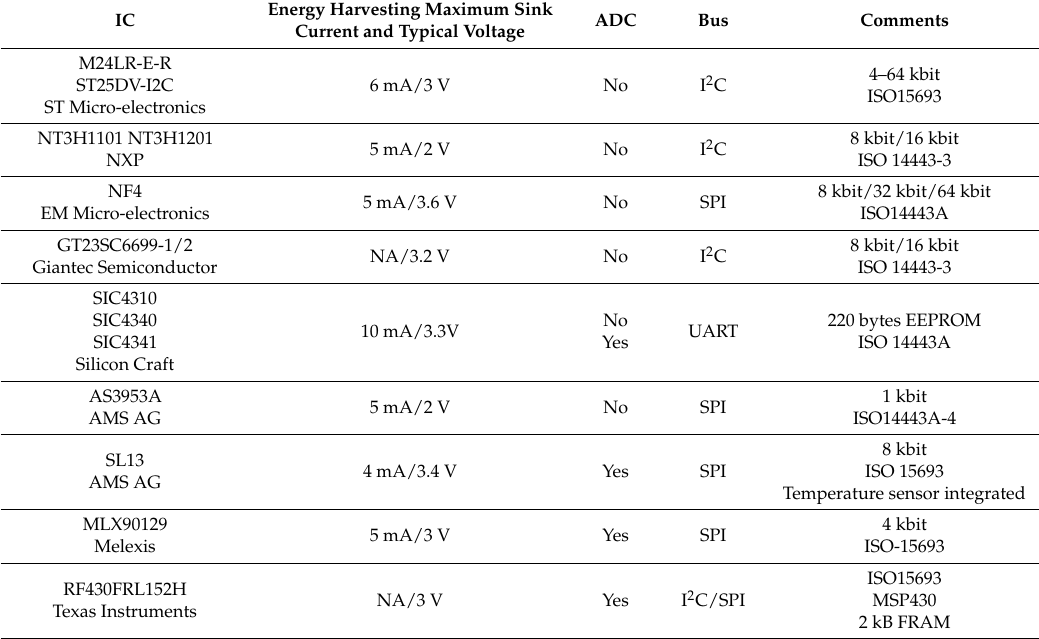
Table 2. Comparison of commercial NFC ICs with energy harvesting. ADC—analog-to-digital converter; SPI—serial peripheral interface; NA—not applicable; UART—universal asynchronous receiver-transmitter.